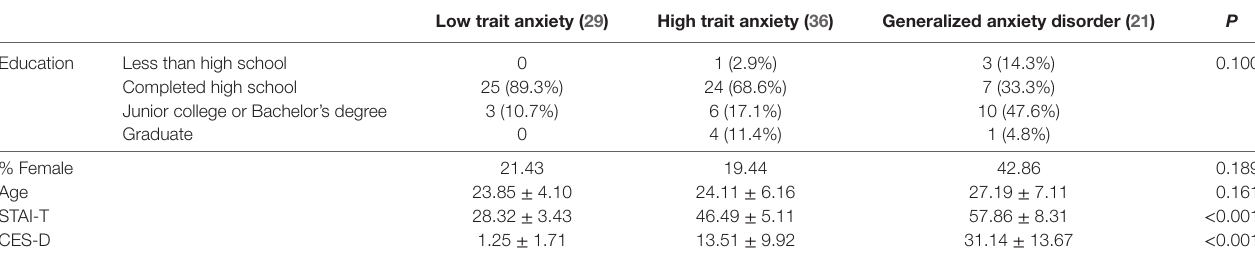
TaBle 1 | Demographic and questionnaire data for participants (mean ± SD